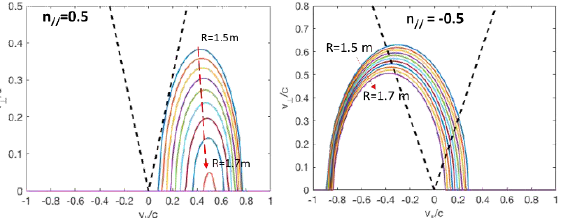
Fig. 1. Two different D oppler-shifted relativistic EC resonance curves using Eq. (2): (left) up-shift resonance and (right) down- shift resonance. The dot line is the trapping boundary. The arrow indicates different radial position of the vertical trajectory from R = 1.5 m to 1.7